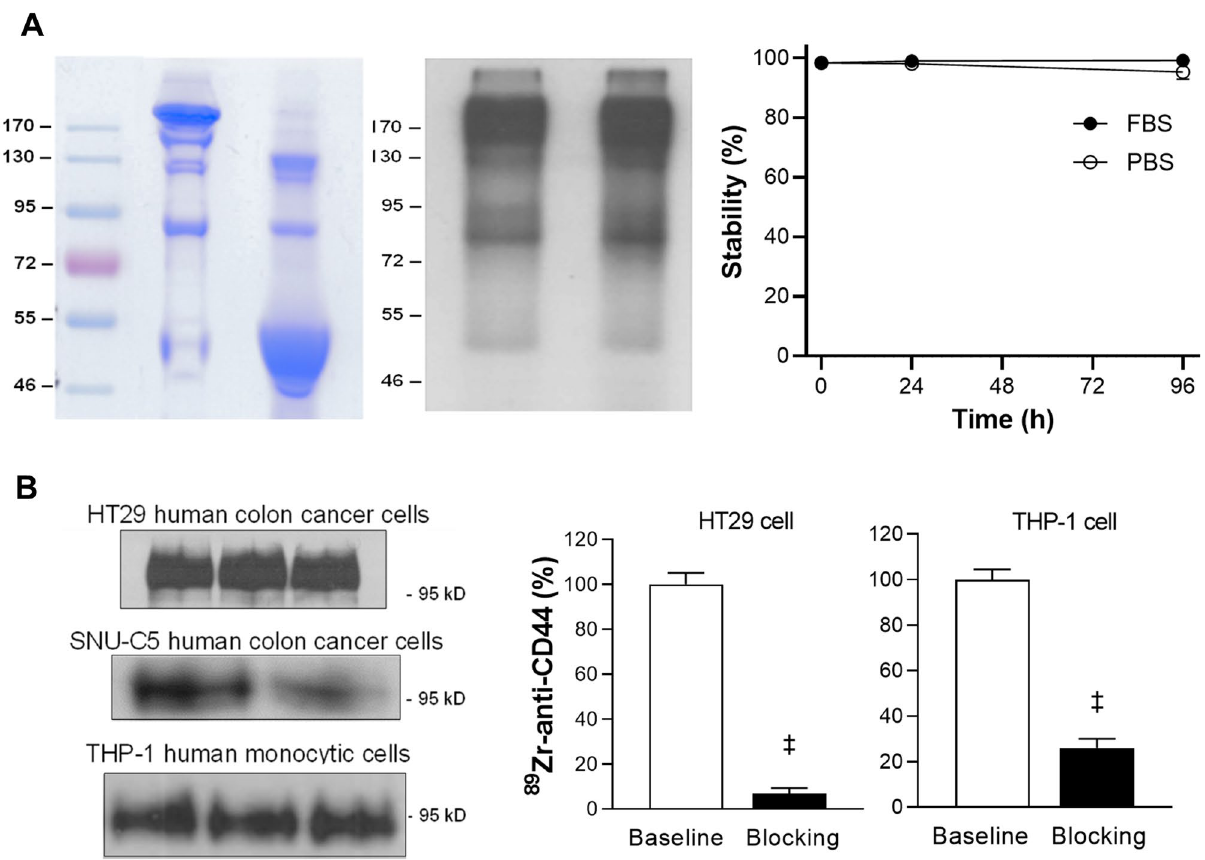
Figure 1. 89 Zr-anti-CD44 preparation, stability, and CD44-specific binding. ( A ) Non-reduced SDS polyacrylamide gel electrophoresis (PAGE) of unmodified and deferoxamine-conjugated anti-CD44 (left). Autoradiograph of 89 Zr-anti-CD44 on native PAGE (middle), and in vitro stability in PBS and FBS (n = 4) assessed by radio-instant thin layer chromatography (right). ( B ) CD44 expression on HT29 human colon cancer cells and THP-1 human monocytic cells (left). Blots were cropped to combine into a single figure (see supplementary Fig. S1 for the full-length blots). CD44-specific cell binding of 89 Zr-anti-CD44 that was blocked by excess (500 nM) cold anti-CD44 (right). Bars are mean ± S.D. of % bound activity from triplicate samples per group. ‡ P >